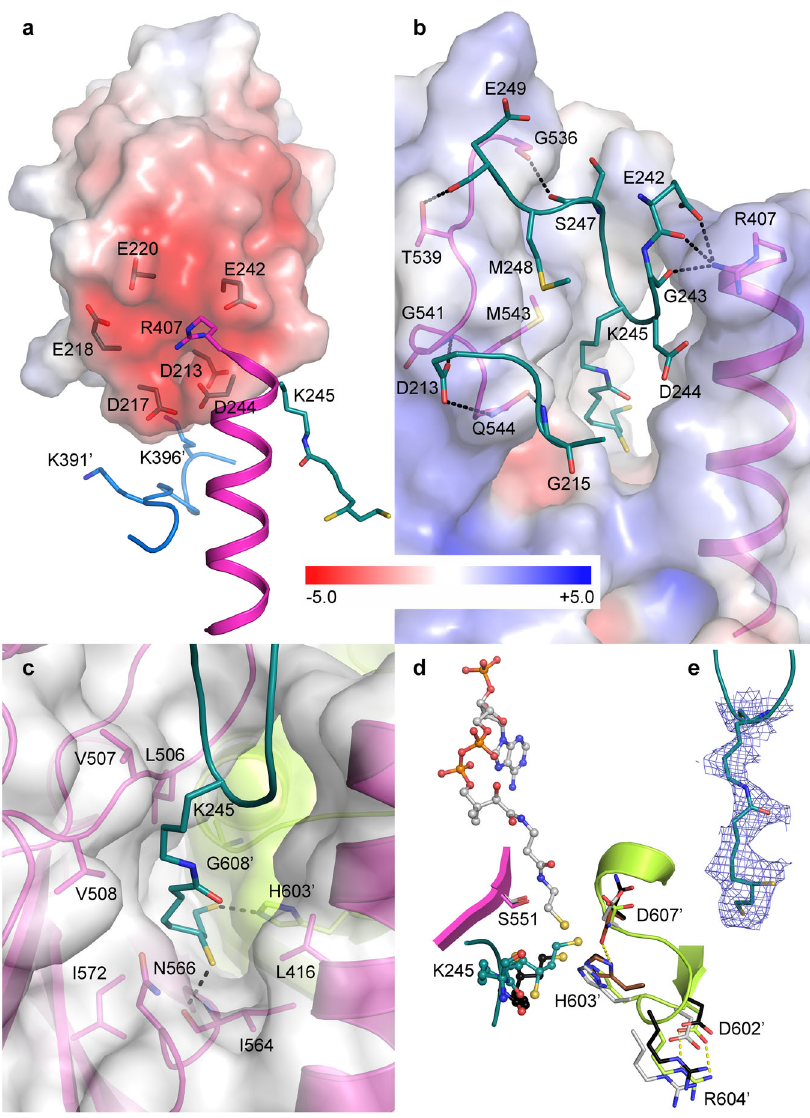
Fig. 3 Interaction of the lipoyl domain with the catalytic domain of E. coli dihydrolipoyl transacetylase. The color code for the individual domains corresponds to Fig. 2b. a Acidic patch on the surface of lipoyl domain interacts with the positive dipole and an arginine residue in the N-terminal tip of the catalytic domain helix H1, and with two basic residues from the N-terminal stretch of the neighboring catalytic domain. Residue D213 lies on the backside of the lipoyl domain. b Key interactions are visualized between the loops of the lipoyl and catalytic domains at the binding interface located around the entrance into the active site channel. In a , b , key residues are shown as sticks and surfaces of the lipoyl ( a ) and catalytic ( b ) domains are colored based on the electrostatic potential (values in kT/e). c Interaction of the dihydrolipoyllysine residue (cyan) with the residues in the active site channel at the interface of two catalytic domains (magenta and green, respectively). d Comparison of the active site of E. coli E2p (color code is the same as in b ) with the structures of the complexes of Azotobacter vinelandii E2p with dihydrolipoate (PDB code 1eae, black) and oxidized CoA (PDB code 1ead, brown; only the catalytic His and Asn are shown) 70 , and Bos taurus E2b with CoA (PDB code 2ii4, light gray) 72 . Residue numbers correspond to E. coli E2p. e Cryo-EM map for the dihydrolipoyllysine